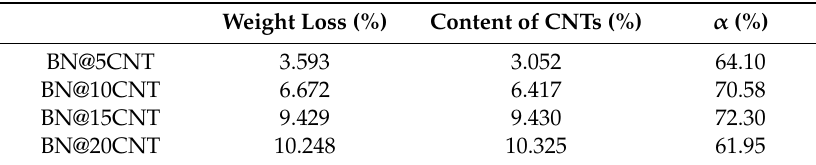
Table 2. Calculated results of content of CNTs and corresponding data used.